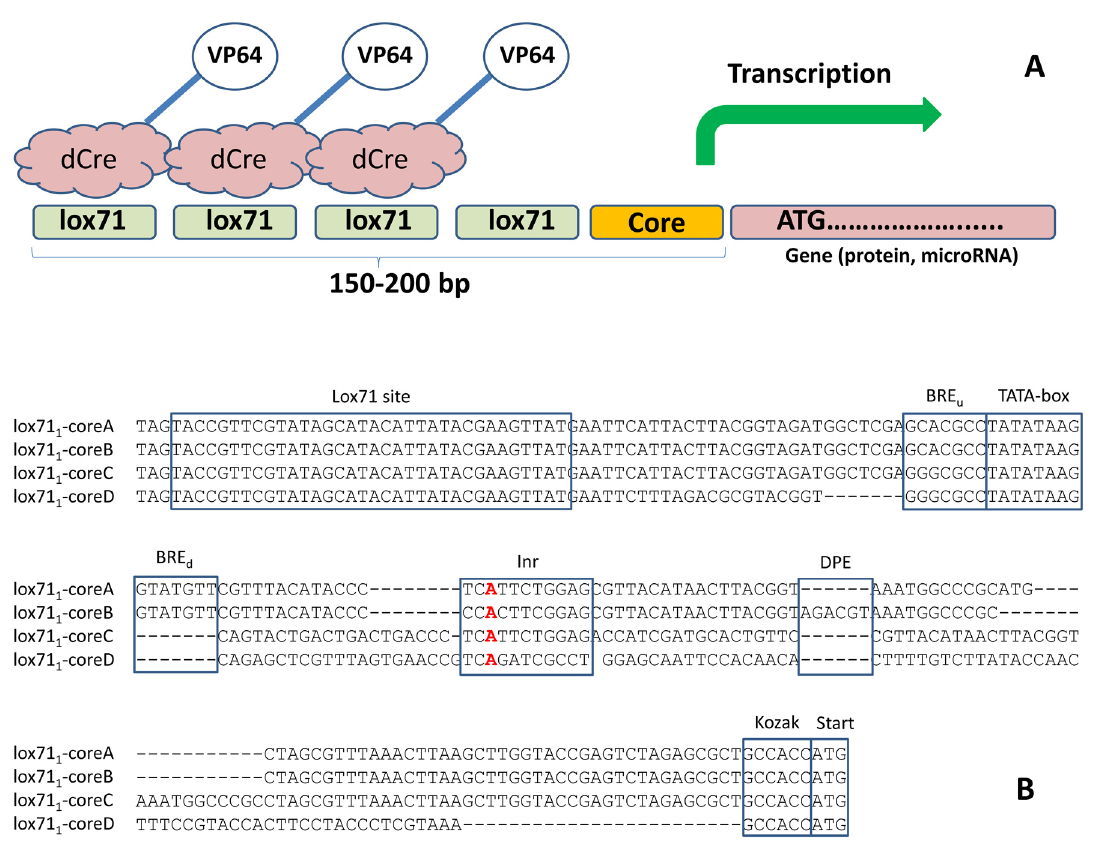
Figure 2. The design of the minimal promoters. ( A ) The scheme for the dCre-VP64 interaction with the core promoter. The positions of multiple lox71 sites are shown. ( B ) The sequences of the developed promoters, which bind the dCre-VP64 transactivator. The transcription initiation site is highlighted in